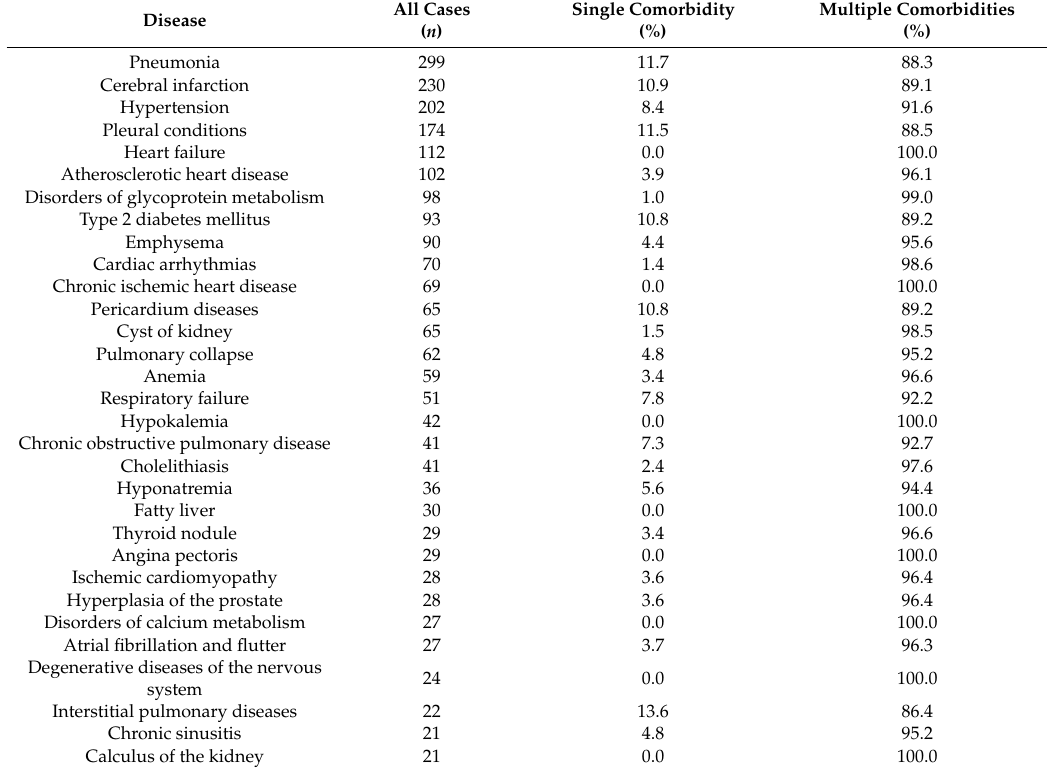
Table 2. Patients a ff ected by each disease independent of comorbidities (all cases) and by each disease with a single comorbidity and multi-comorbidities.